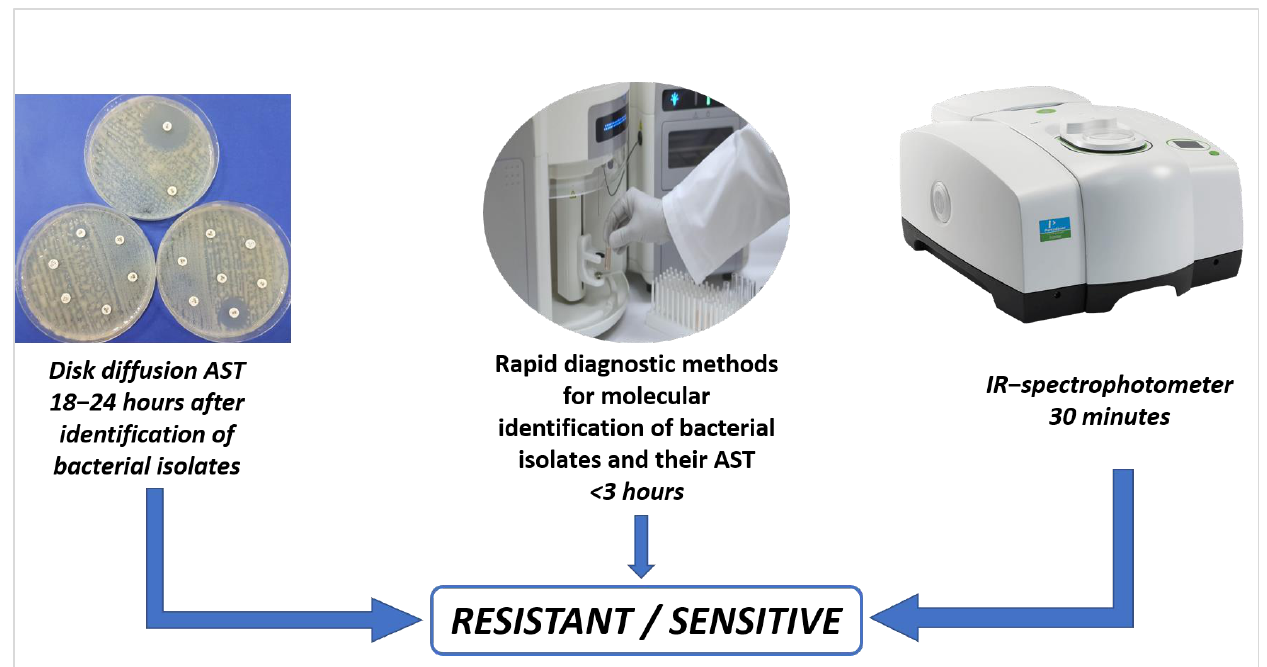
Figure 3. Gold standards method for AST (disc diffusion) vs. automation methods.